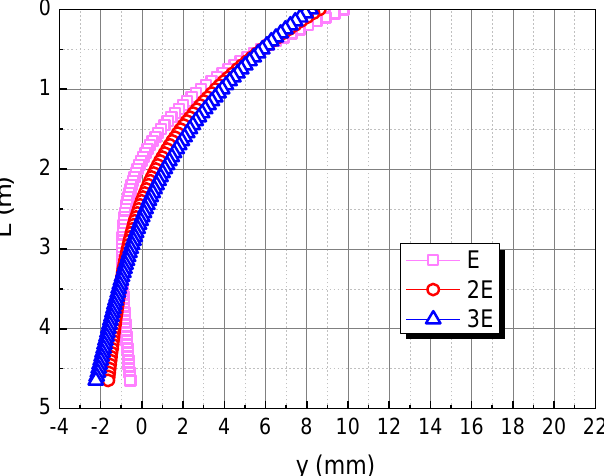
Figure 8. Effect of elastic modulus of pile on horizontal displacement of pile in calcareous sand area.